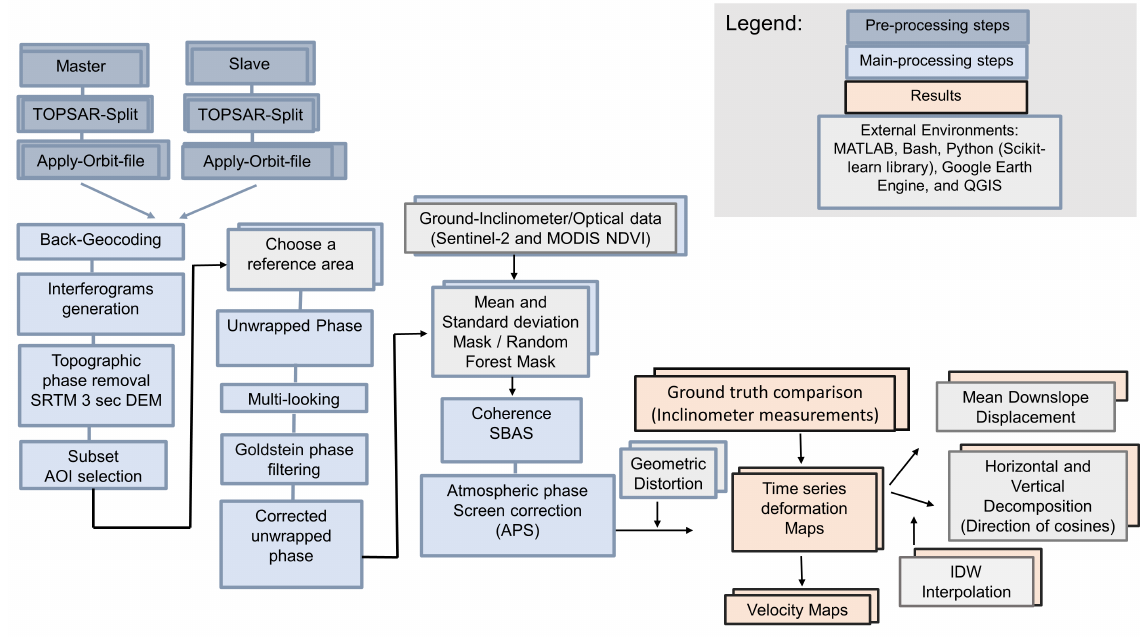
Figure 7. Flowchart of the processing steps implemented in this